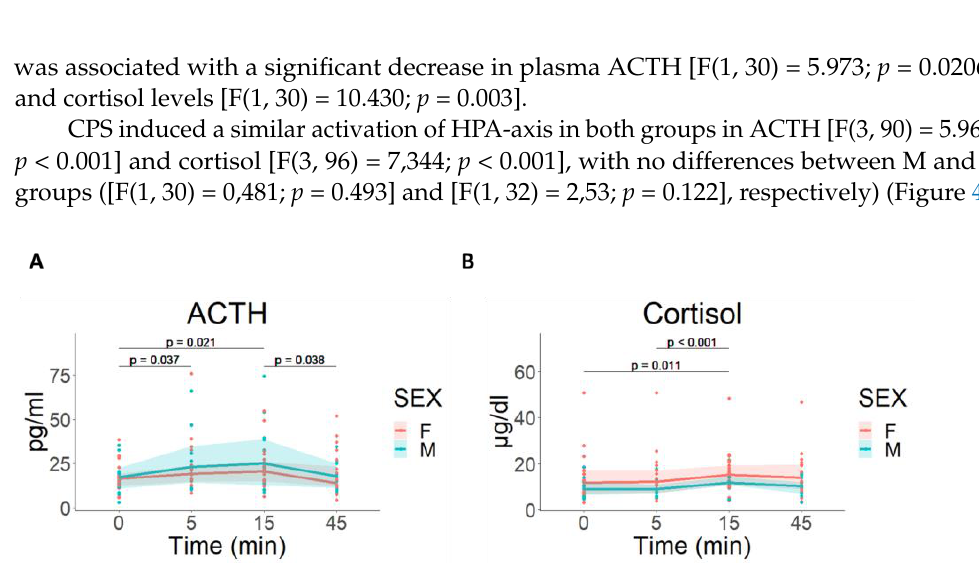
Figure 4. Hormonal response to CPS. ( A ) ACTH: A two-way ANOVA revealed significant differences for time, but not for sex groups. ( B ) Cortisol: A two-way ANOVA revealed significant differences for time, but not for sex groups. Males and females are represented with blue circles and pink circles, respectively. Lines represent the median for each time point and the area represents the 25 and 75 percentiles. ACTH: adrenocorticotropic hormone; CPS: cold pain stress; F: females; M: males; min: minutes.